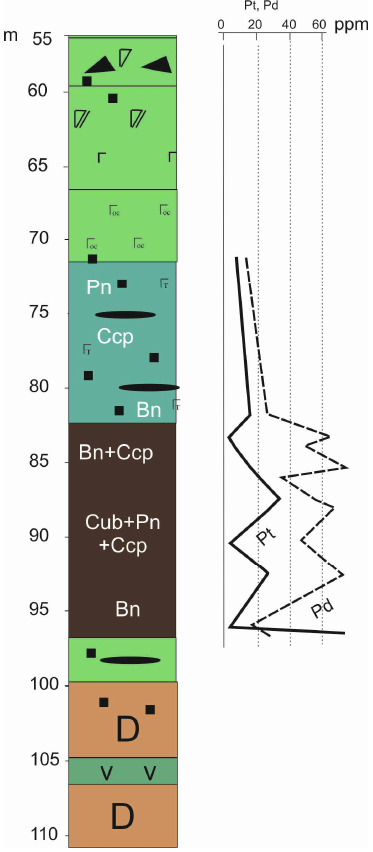
Figure 8. Structure of South-Western branch in borehole EM-6 and PGE distribution in ore. Data in Table